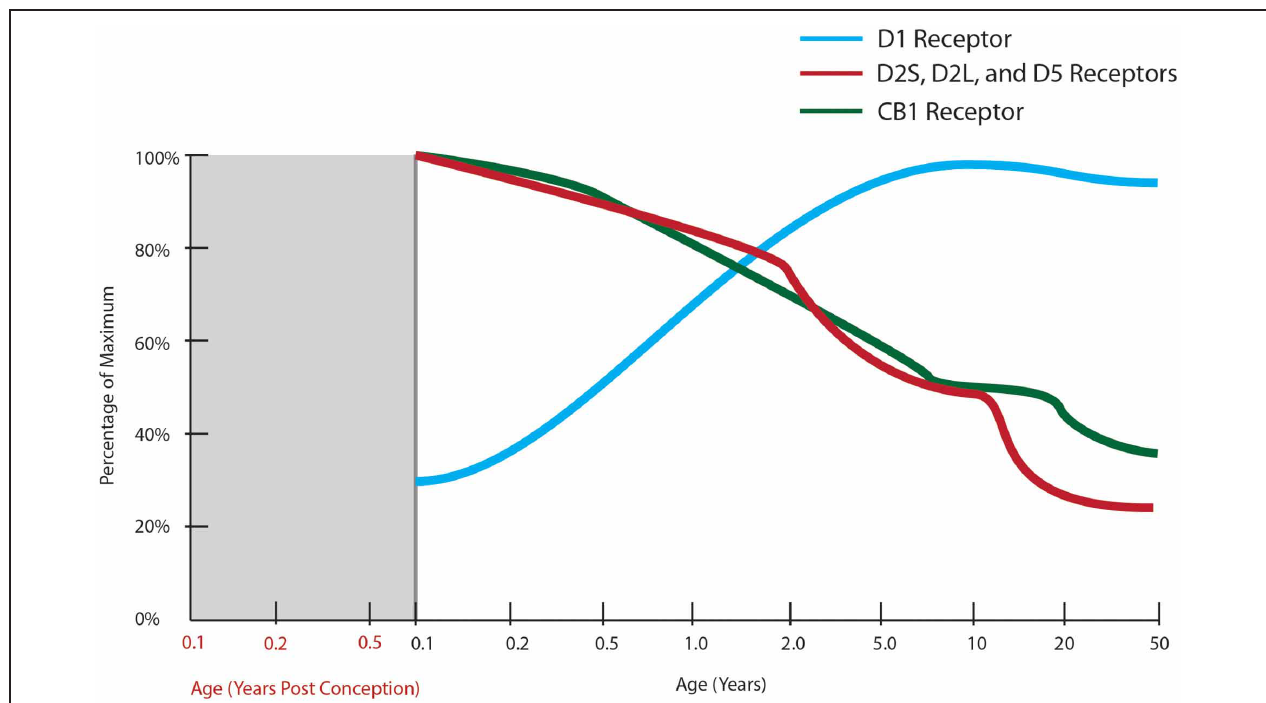
et al., 2012). The expression of DRD4 as determined by in situ hybridization is stable across the lifespan (Weickert et al., 2007). Measurement of this receptor by quantitative PCR has been quite variable and no statistical differences in expression across age groups have been detected (Rothmond et al., 2012). Cannabinoid receptor mRNA has its highest measured expression at the time of birth and shows a stepwise decline with age, reaching 30% of maximal expression in middle age (Long et al.,